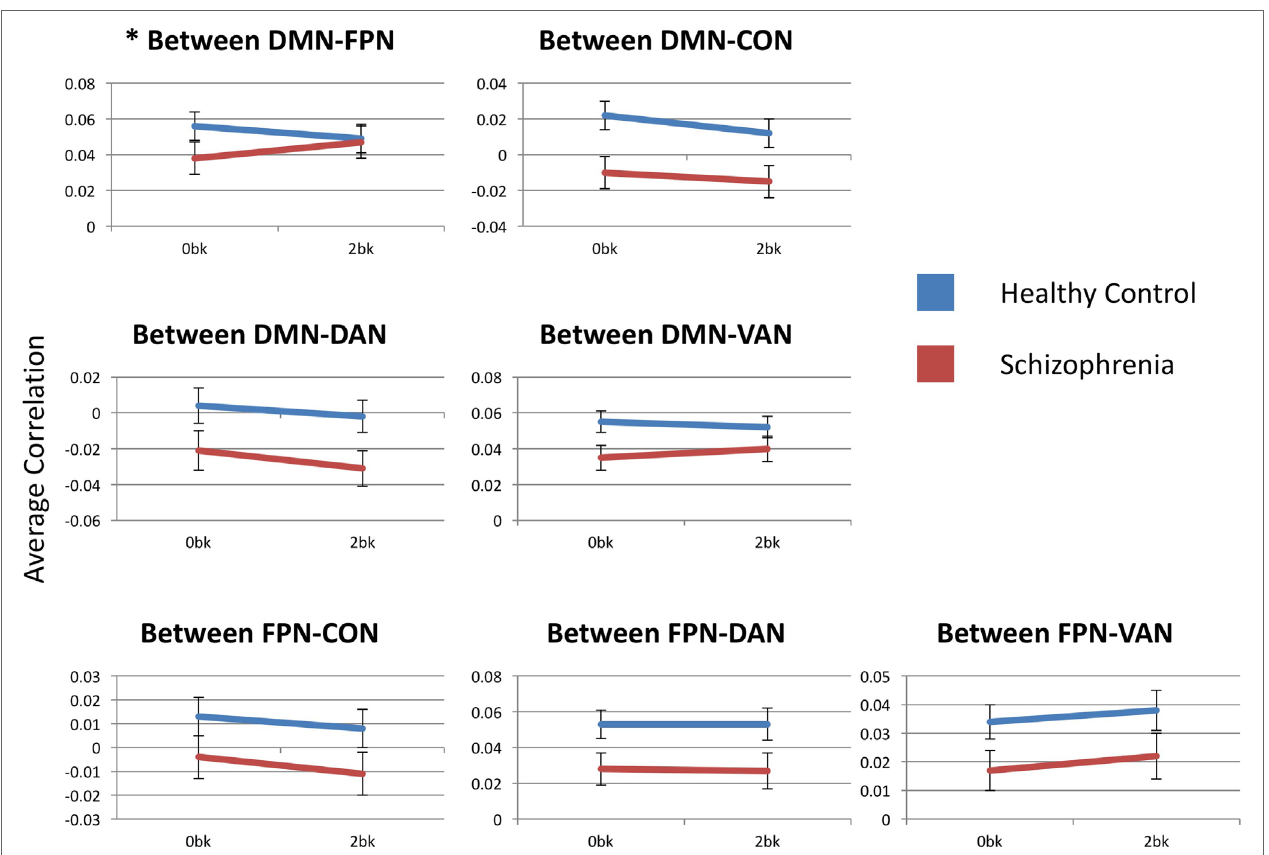
FigUre 4 | Between-network functional connectivity across group and condition. Each graph presents the average between-network correlation coefficients ( y -axis) for each of the seven tested connections. DMN, default mode network; FPN, frontoparietal network; CON, cingulo-opercular network; DAN, dorsal attention network; VAN, ventral attention network. Asterisks indicate statistical significance ( p = 0.05) for group × condition effect. Error bars represent